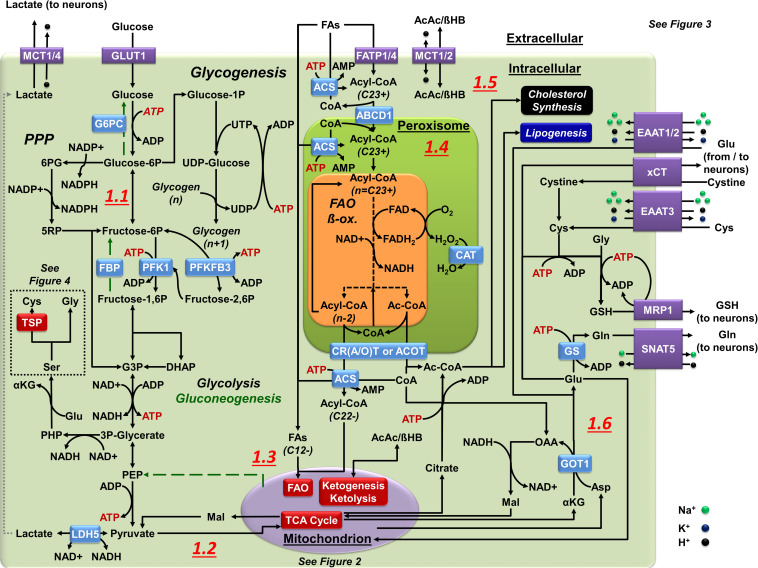
Central carbon metabolism in astrocytes. (1.1) In astrocytes, glucose is used via glycolysis as a principal energy source. The PPP creates redox potential by replenishing the NADPH pool. Glucose storage in glycogen is restricted or transient at most. Glucose carbons can also be used for cysteine (Cys, via TSP) and glycine (Gly) synthesis using serine (Ser) as a precursor. Gluconeogenesis (green broken arrows) is astrocyte-specific as they express FBP and G6PC but it requires metabolism of OAA to PEP in the mitochondria. (1.2) Pyruvate is the principal end product of glycolysis in astrocytes. Astrocytes convert most pyruvate into lactate by LDH5 to be exported to the extracellular space. Pyruvate also enters the mitochondria (see Figure 2 for details). (1.3) FAs are sorted by their size: 12 or less carbons can directly enter the mitochondria (SCFAs or MCFAs), 13–21 carbons (LCFAs) pass into the mitochondria through a shuttle (see Figure 2 for details), and 22+ carbons (VLCFAs) enter peroxisomes to create shorter FA products through α/β-oxidation. The esterification of FAs (ACS) limits their ability to pass through membranes, and is required for FAO. (1.4) Peroxisomal α/β-oxidation occurs in a similar manner to mitochondrial FAO but, without an ETC, FADH2 donates its electrons directly to O2 to create H2O2 that is neutralized by CAT. Multiple mechanisms of FA transport systems exist within peroxisomes, each with different affinities for various FA lengths. Exported FAs enter the mitochondria to complete FAO. (1.5) Ketone bodies in astrocytes can enter as substrates for mitochondrial metabolism (see Figure 2 for details) or can be the end product in mitochondrial metabolism that astrocytes export for other cells (neurons). (1.6) Astrocytes utilize glutamate (Glu) for glutamine (Gln) synthesis (Glu-Gln cycle), Cys acquisition (xCT or EAAT3), and for GSH synthesis, this later exported via (MRP1). In astrocytes, Glu is imported from the synaptic cleft by EAAT1/2 or derived from transamination of the mitochondrial TCA intermediate αKG by aspartate (Asp) amino transferases (GOT1/2). Glu can also be used to power the malate (Mal)-Asp shuttle through AGC, or enter the mitochondria as a substrate for OXPHOS (see Figure 2 for details).